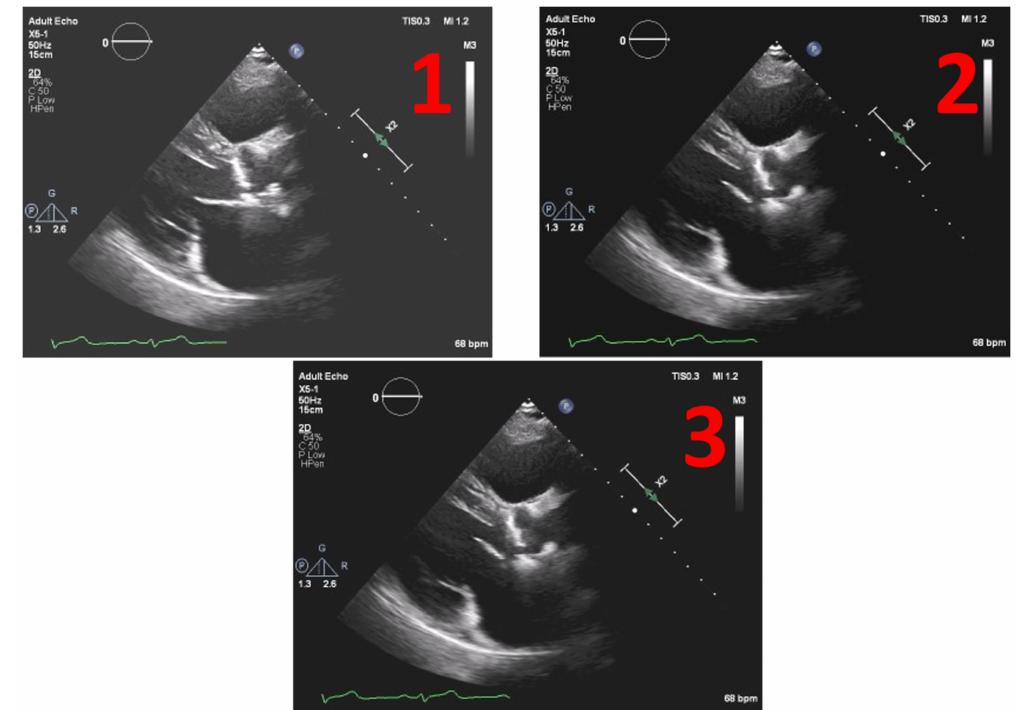
Figure 8. Echocardiography examples with different Windrow Levels (WL) and fixed Window Width of 250 ( 1 ) WL = 75, ( 2 ) WL = 100, and finally, ( 3 ) WL = 125.